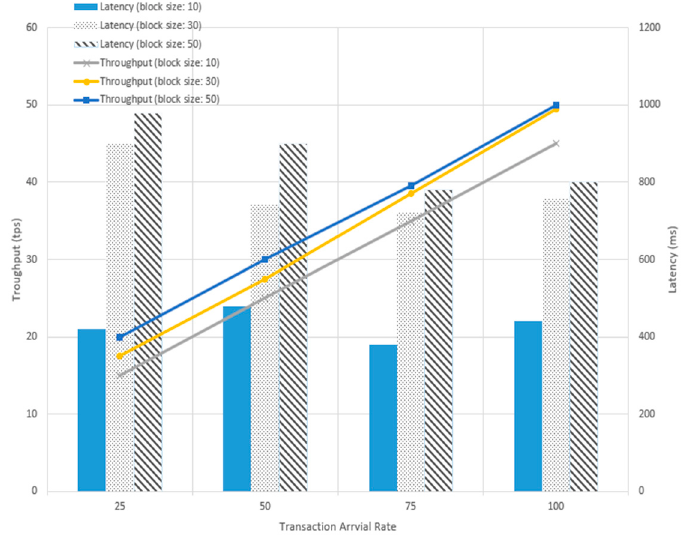
Figure 5. Time cost of storing data information on the blockchain for different block sizes and transaction arrival rates.